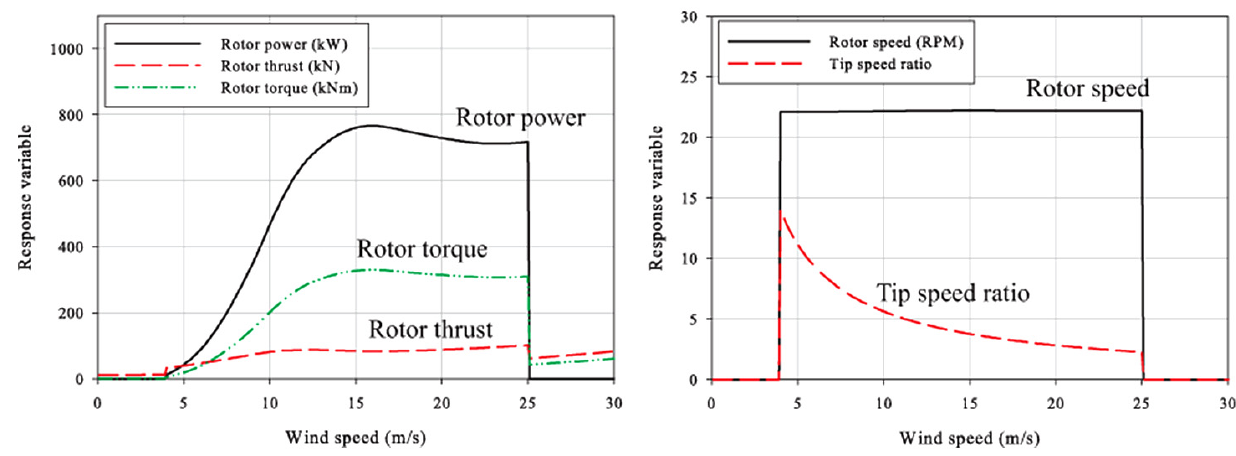
Figure 2. Drive train configuration of the wind turbine